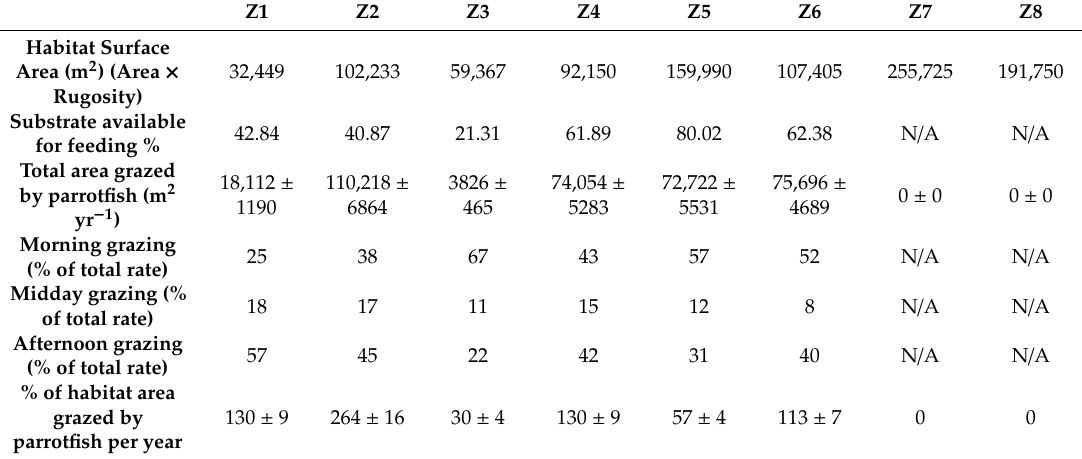
Table 4. Surface area of each habitat and the % of substrate available for feeding. The total area of substrate grazed by parrotfish per year in each habitat is presented, along with the % that occurs in the morning (sunrise–11:30), at midday (11:30–14:00), and in the afternoon (14:00–sunset). Note that